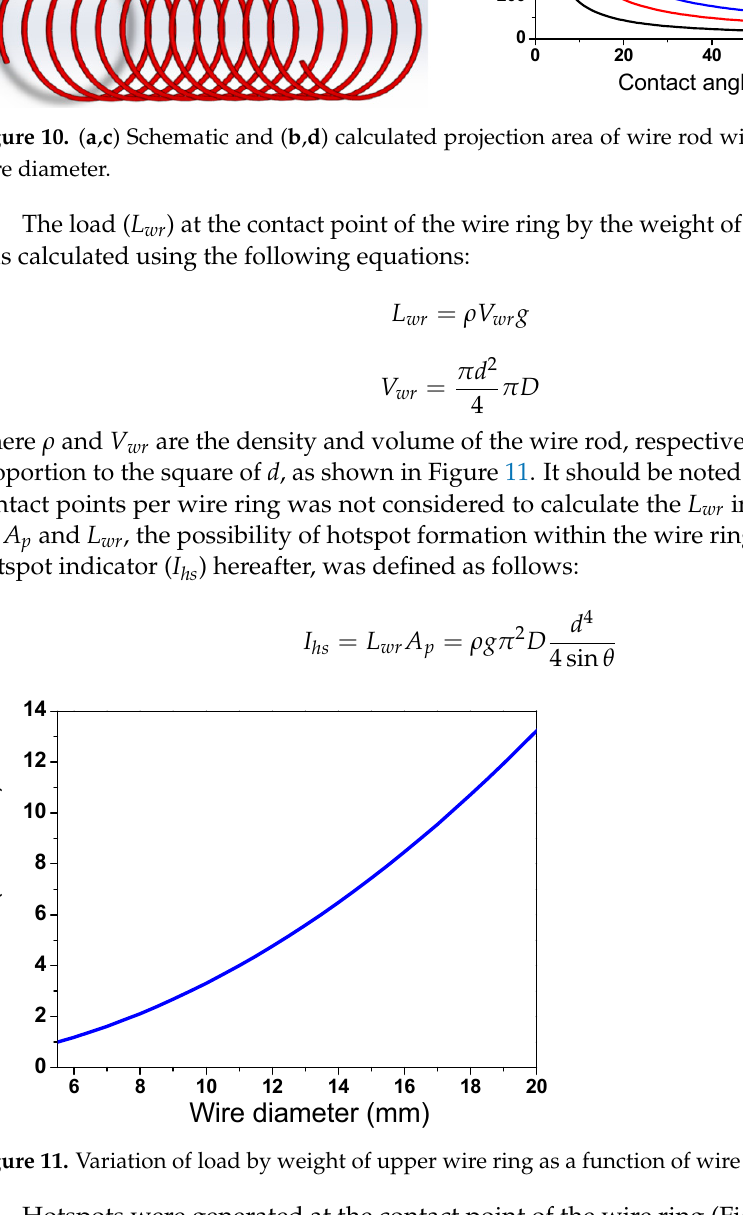
Figure 11. Variation of load by weight of upper wire ring as a function of wire diameter.